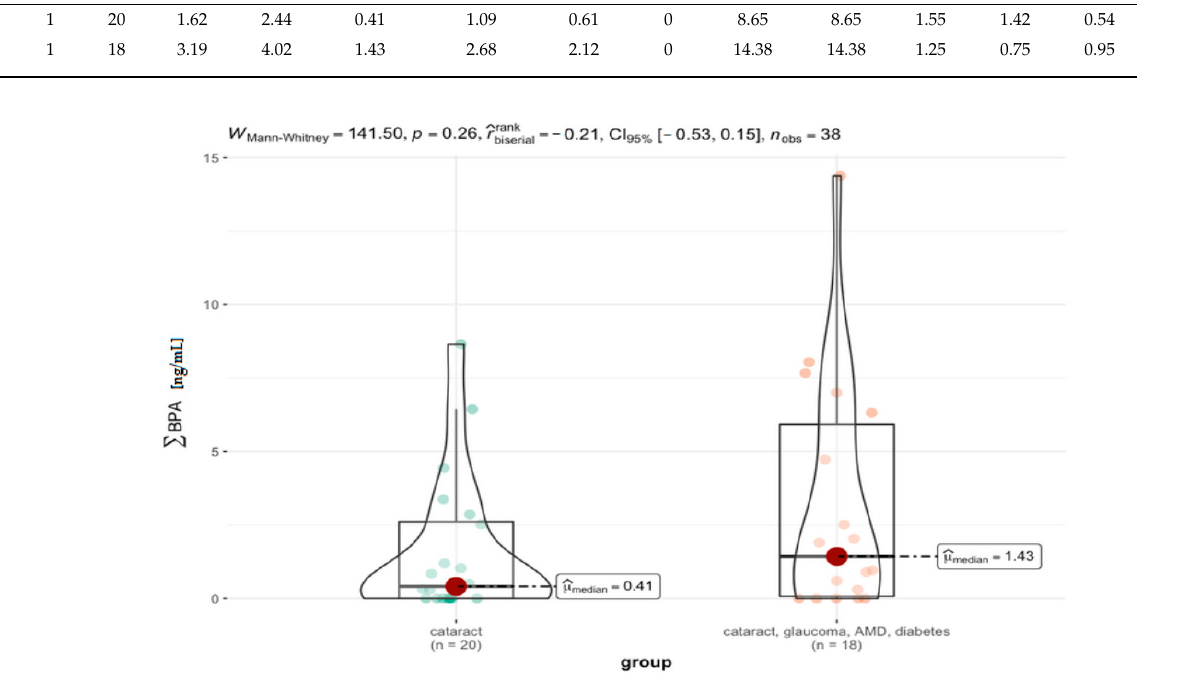
Figure 8. Statistical significance of differences in BPs’ content in AH for cataract and cataract with coexisting ocular pathologies (AMD, glaucoma) and diabetes.